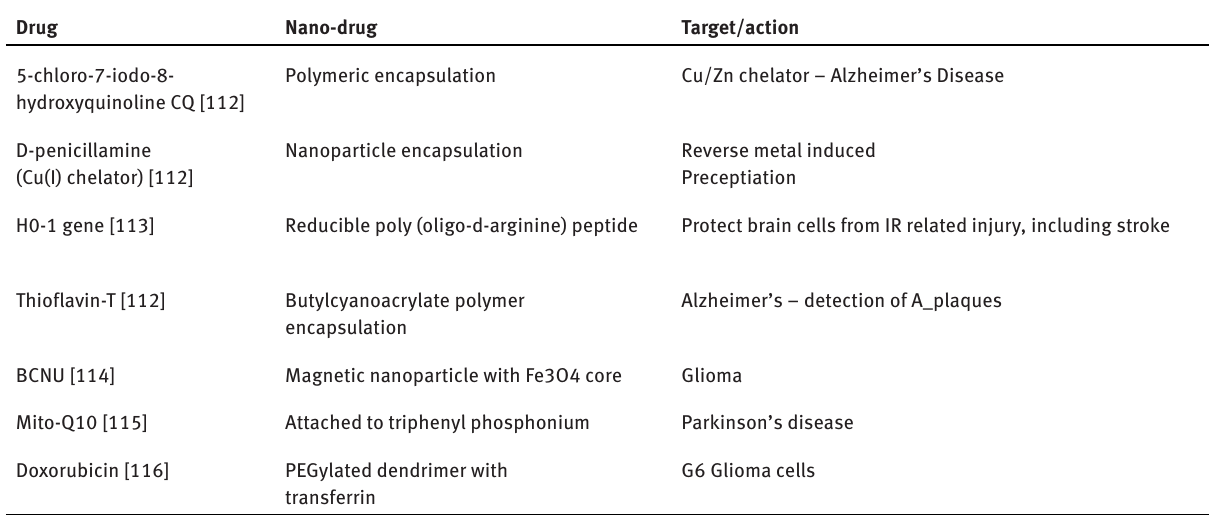
Table 6: Some of the nanobased neurological drugs currently used to treat neuronal diseases